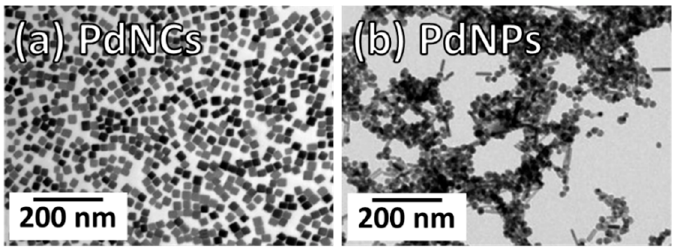
Figure 7. TEM images of ( a ) the PdNCs and ( b ) the PdNPs for morphology observations. (Repro- duced with permission from [34]. Copyright Elsevier,